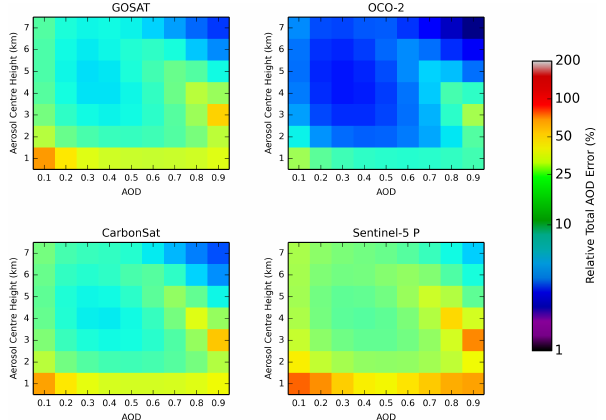
Figure 9. Relative AOD error as a function of aerosol centre height and AOD for the parameterised aerosol retrieval for a SZA of 30 ◦ and albedo of 0.5. Intensity offset is included.